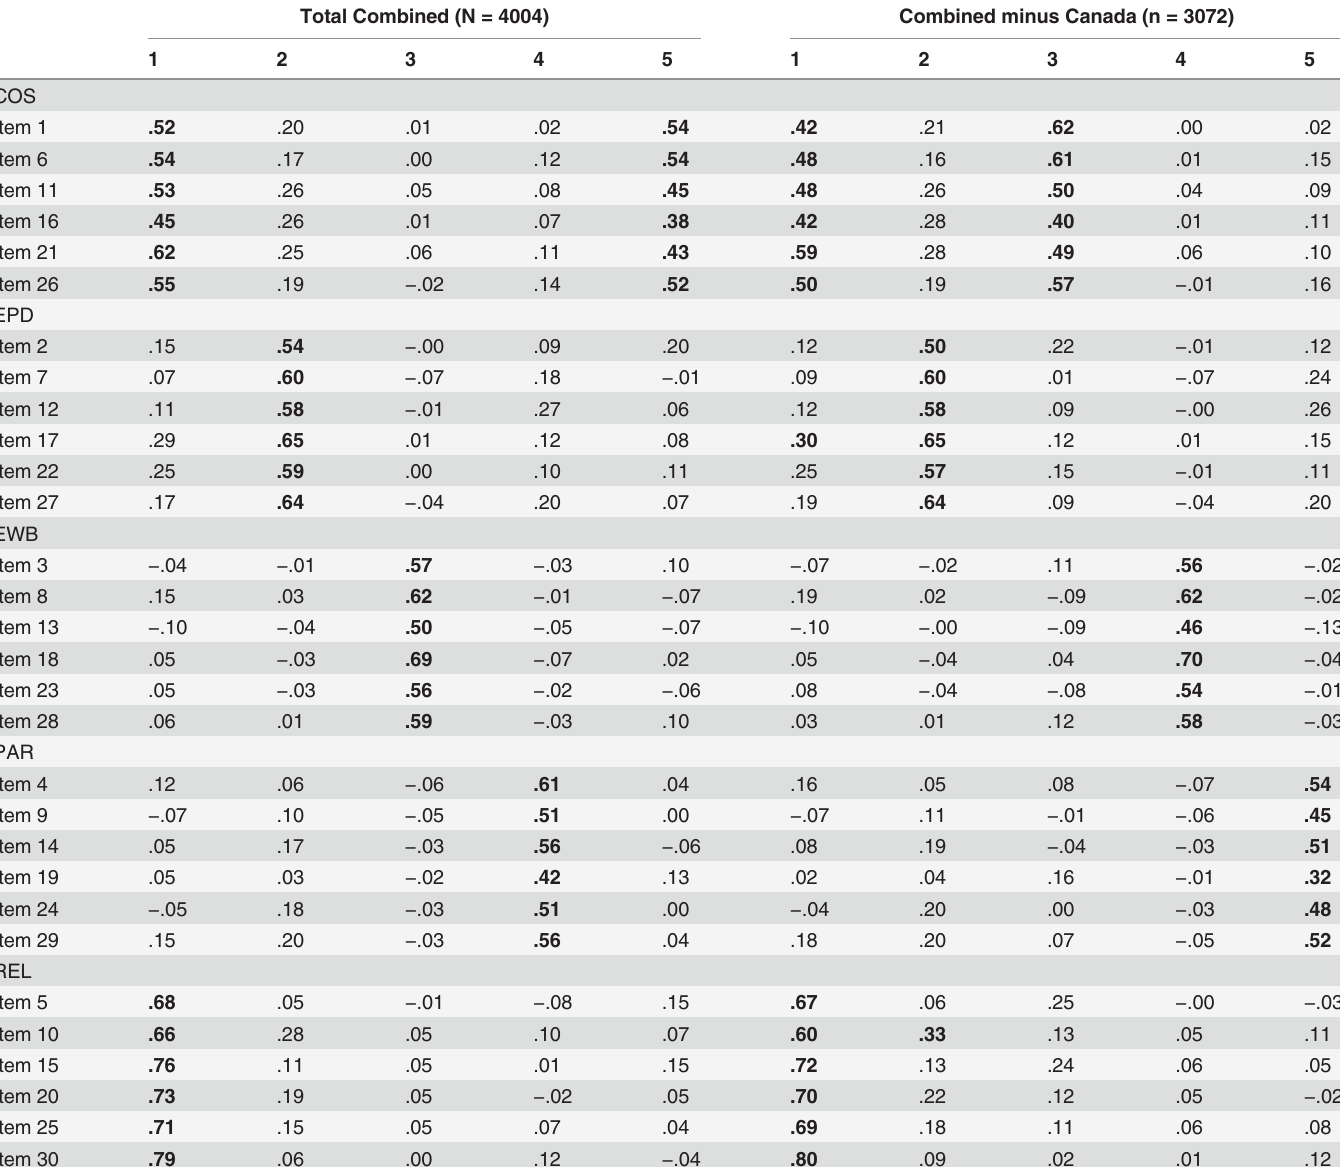
Table 9. Varimax Rotated Factor Loadings from Principal Axis Factor Analyses of ESI-R Items Using Total Combined Sample and Combined Sample Minus Canadian